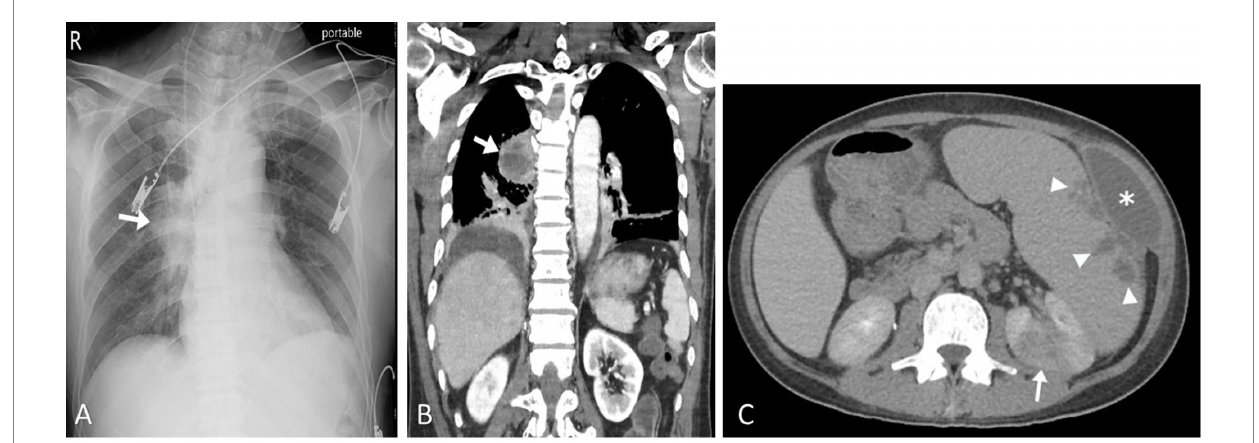
FIGURE 1 Pulmonary melioidosis of case 1 and splenic abscess and pyelonephritis of case 8. Chest radiograph showed radiopacified lesion in right middLe lung field (arrow) (A) . Coronal computed tomography image (soft tissue window setting) confirmed an area of consolidation with cavitation in the right lower lobe, compatible with abscess formation (arrow) (B) . Contrast-enhanced axial computed tomography image showed enlargement of the spleen as well as multiple splenic abscesses (arrow heads) and left anterior abdominal wall abscess (asterisk). Left renal cortex also showed focal pyelonephritis (arrow) (C)